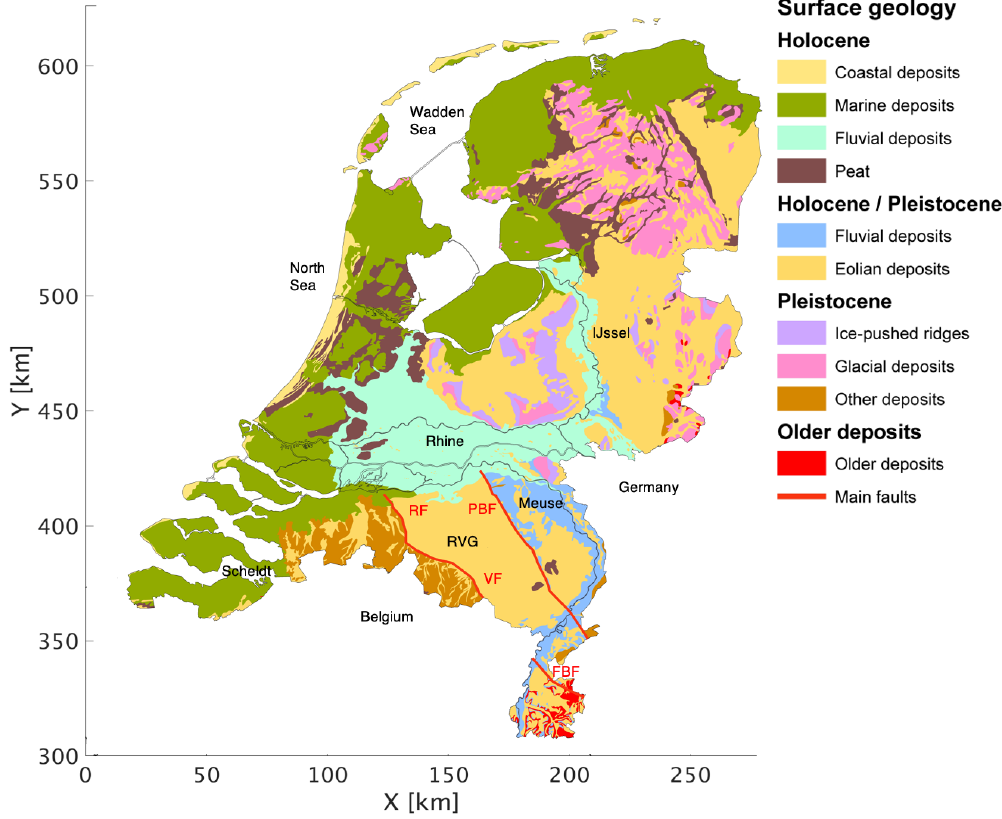
Figure 1. Surface geological map of the Netherlands. Older deposits comprise unconsolidated Neogene and Paleogene deposits as well as Mesozoic and Carboniferous limestones, sandstones, and shales. Modified after Schokker (2010). RF: Rijen Fault; VF: Veldhoven Fault; PBF: Peel Boundary Fault; FBF: Feldbiss Fault; RVG: Roer Valley